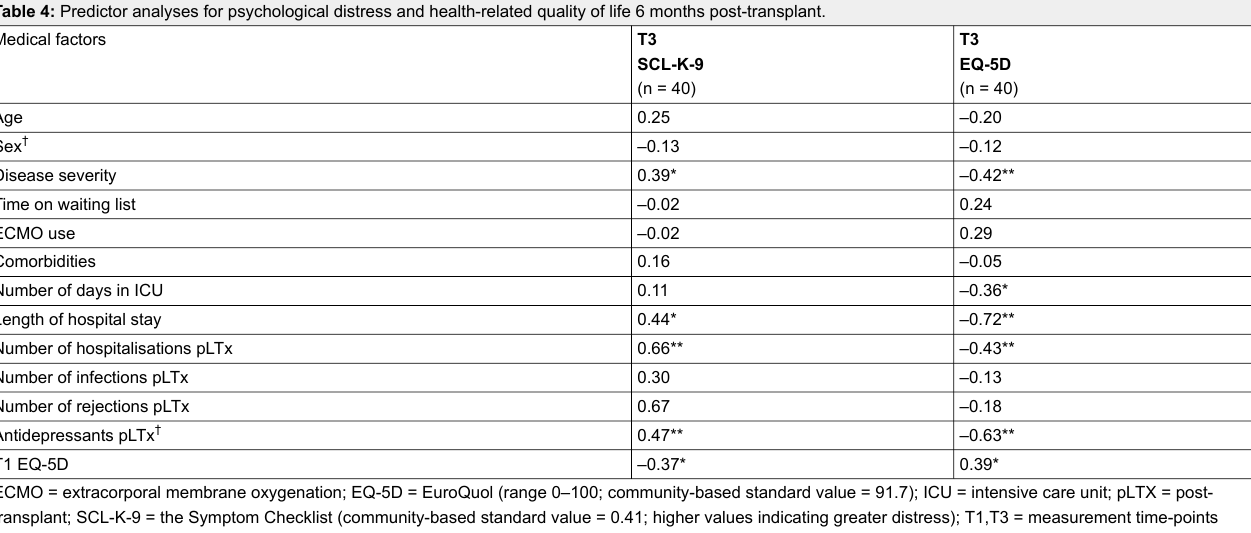
Table 4: Predictor analyses for psychological distress and health-related quality of life 6 months